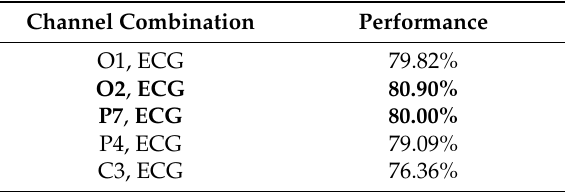
Table 5. System accuracy using different combinations of EEG electrodes with